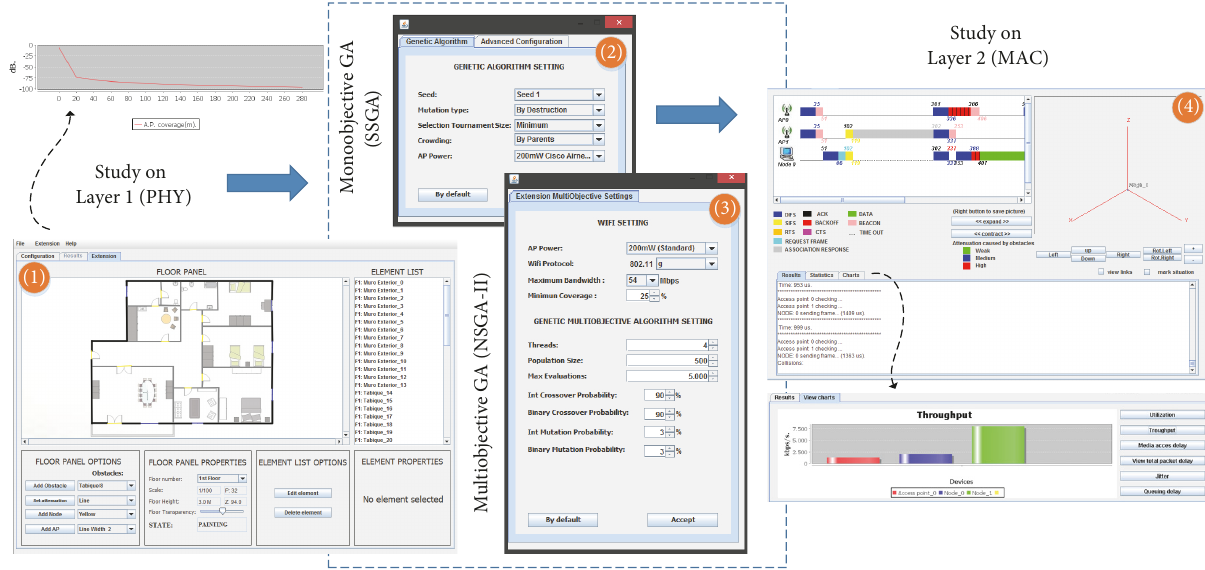
Figure 1: WiFiSim’s control panel: (1) graphical deployment for Layer 1, (2) steady-state GA module, (3) multiobjective GA module, and (4) study of Layer